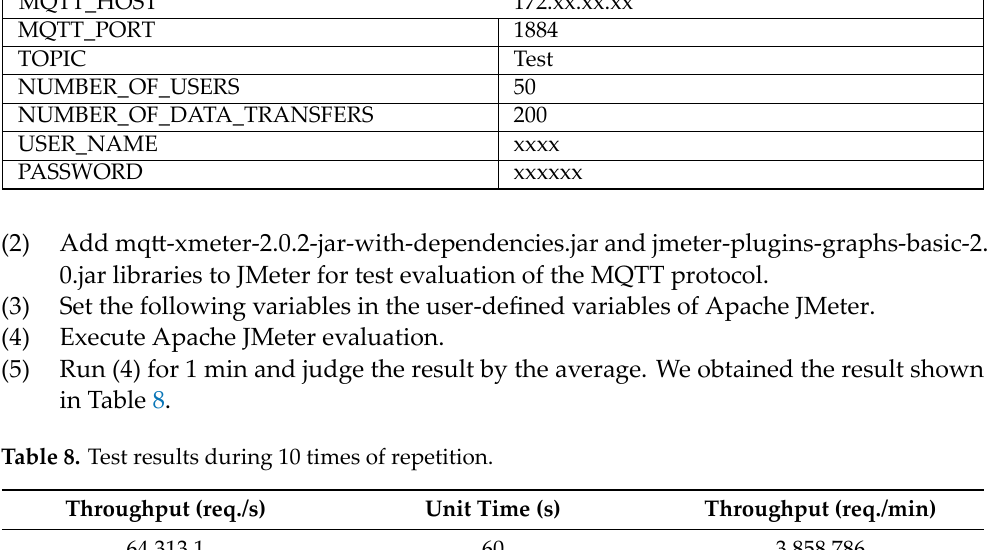
Table 7. Test results during 10 times of repetition.